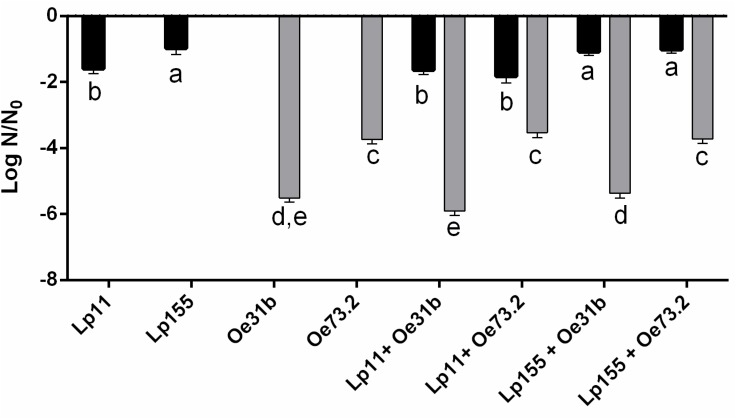
Loss of viability expressed as Log N/N0 of single cultures UNQLp11, UNQLp155, UNQOe31b, UNQOe73.2, and blend cultures UNQLp11/UNQOe31b, UNQLp11/UNQOe73.2, UNQLp155/UNQOe31b, and UNQLp155/UNQOe73.2 after 14 days of incubation in Malbec wine samples at 21°C. Gray bars indicate plate viable cell count number of strains belonging to Oenococcus species; black bars indicate viable cell counts of strains belonging to Lactobacillus species. Control wine showed no significant decrease in Lactobacillus count respect to day 0, but no Oenococcus species were detected after 14 days of MLF. Data are presented as mean ± SD and compared by one-way ANOVA followed by a Tukey post-test for multiple comparisons. Different letters (a–e) denote statistically significant difference (p < 0.05).